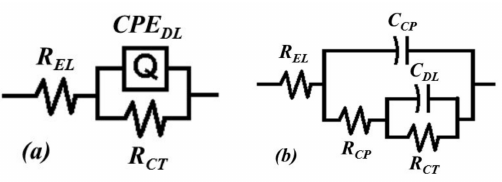
Figure 15. Equivalent circuits for the studied alloy after ( a ) a short time and ( b ) a longer time of immersion in the diluted Harrison